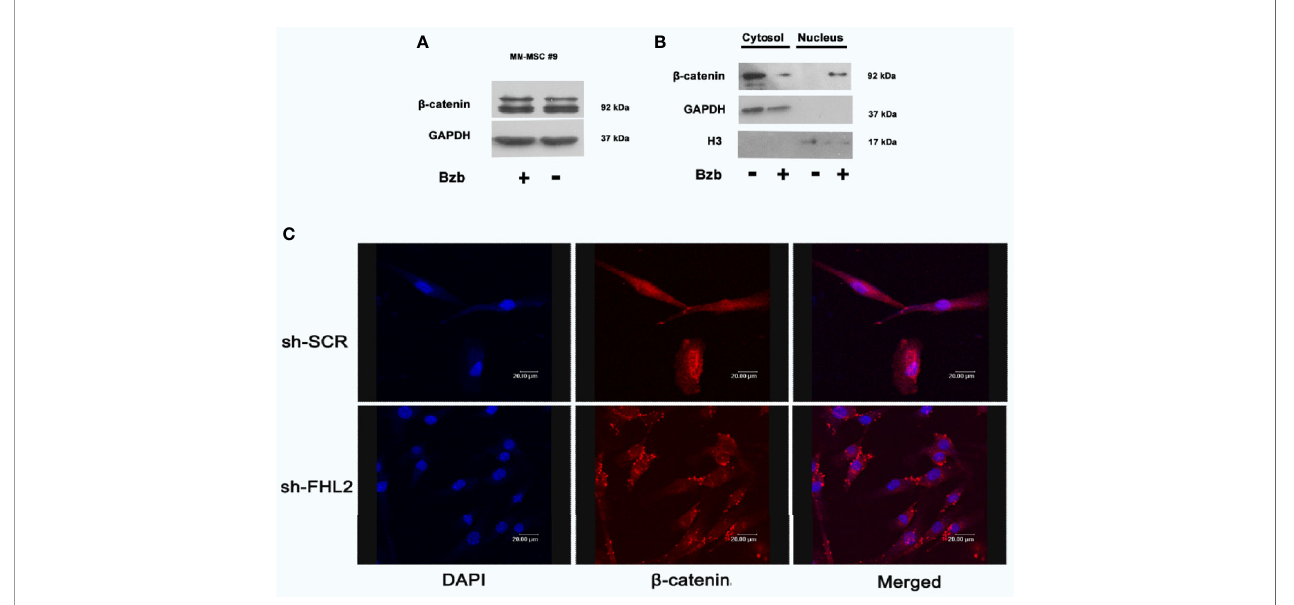
FIGURE 4 | FHL2 is necessary for Bzb-induced b -catenin nuclear enrichment in MM-MSCs. Cells were treated with 2 nM Bzb for 24 h, and the expression of b - catenin was measured by Western blot (A, B) . Immuno fl uorescence microscopy with antibody speci fi c for b -catenin (red) and nuclei (DAPI, blue) were used to show the localization (C) . Scale bars = 20 µm. OBI, osteogenic induction